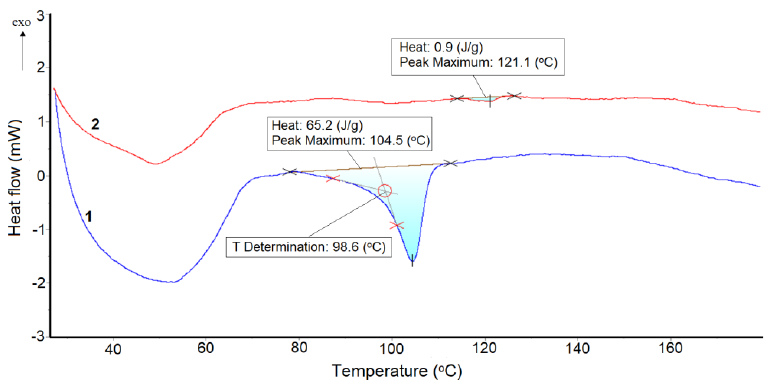
Figure 8. DSC curves of XLPE insulation of IC1 cable (1) and EVA sheath (2) of IC2 cable in a nitrogen atmosphere (50 mL/min.). ATR-FTIR spectroscopy (Figure 9) confirms the DSC data. The most specific band of EVA copolymer is at 1738 cm −1 , assigned to the carbonyl group in esters. This structural band makes the ATR/FTIR method challenging to apply when monitoring the degrada- tion of these materials. Oxidation induced by stress factors results in weaker peaks located at 1680 – 1720 cm −1 . The group of four peaks located between 3300 and 3600 cm −1 and the intense band between 500 and 700 cm −1 are due to the mineral filler. As the vinyl acetate comonomer is free of OH groups, the spectrum of the copolymer should be free of absorption bands in the region of 3200 – 3500 cm −1 ; however a small, straight band is observed at around 3430 cm −1 [59], especially for copolymers with high VA content. These peaks are the result of intramolecular hydrogen bonds within the VA moiety (see the inset in Figure 9 for hydro- gen bonds). However, even if such a peak exists, it is probably masked by more intense bands of the mineral filler. Furthermore, based on the IR spectra, the VA content of 17%